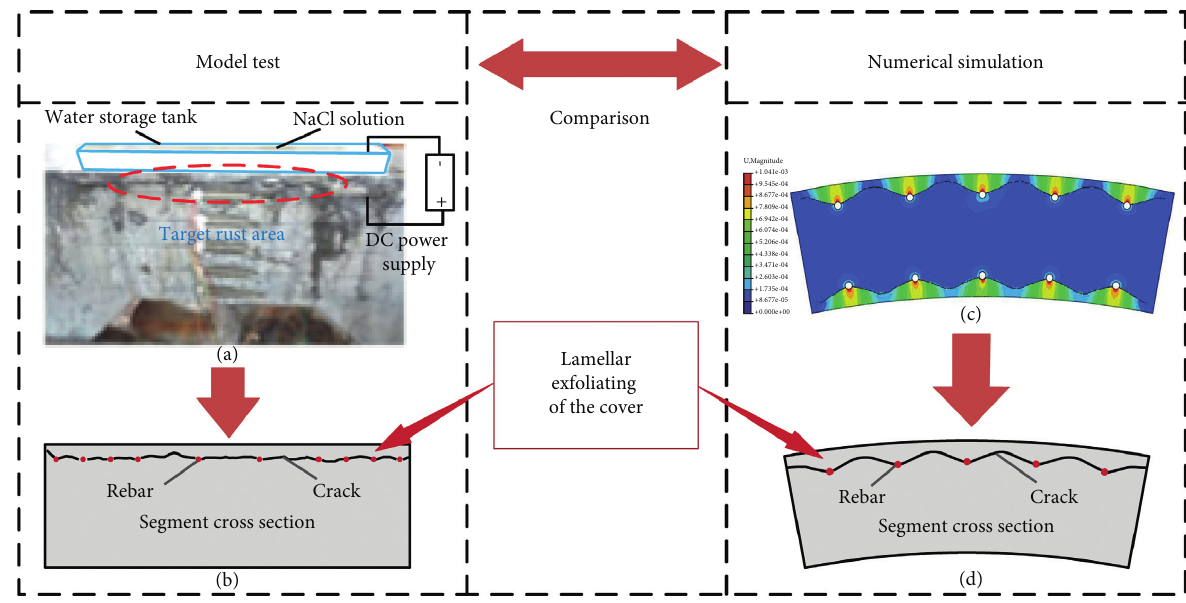
Figure 18: Comparison of segment failure patterns between model test and numerical simulation: (a) experimental setup and failure characteristics of the model test, (b) failure pattern observed from model test, (c) the displacement cloud when segments failure, and (d) failure pattern observed from numerical simulation. Table 6: Comparison of parameters between model test and numerical